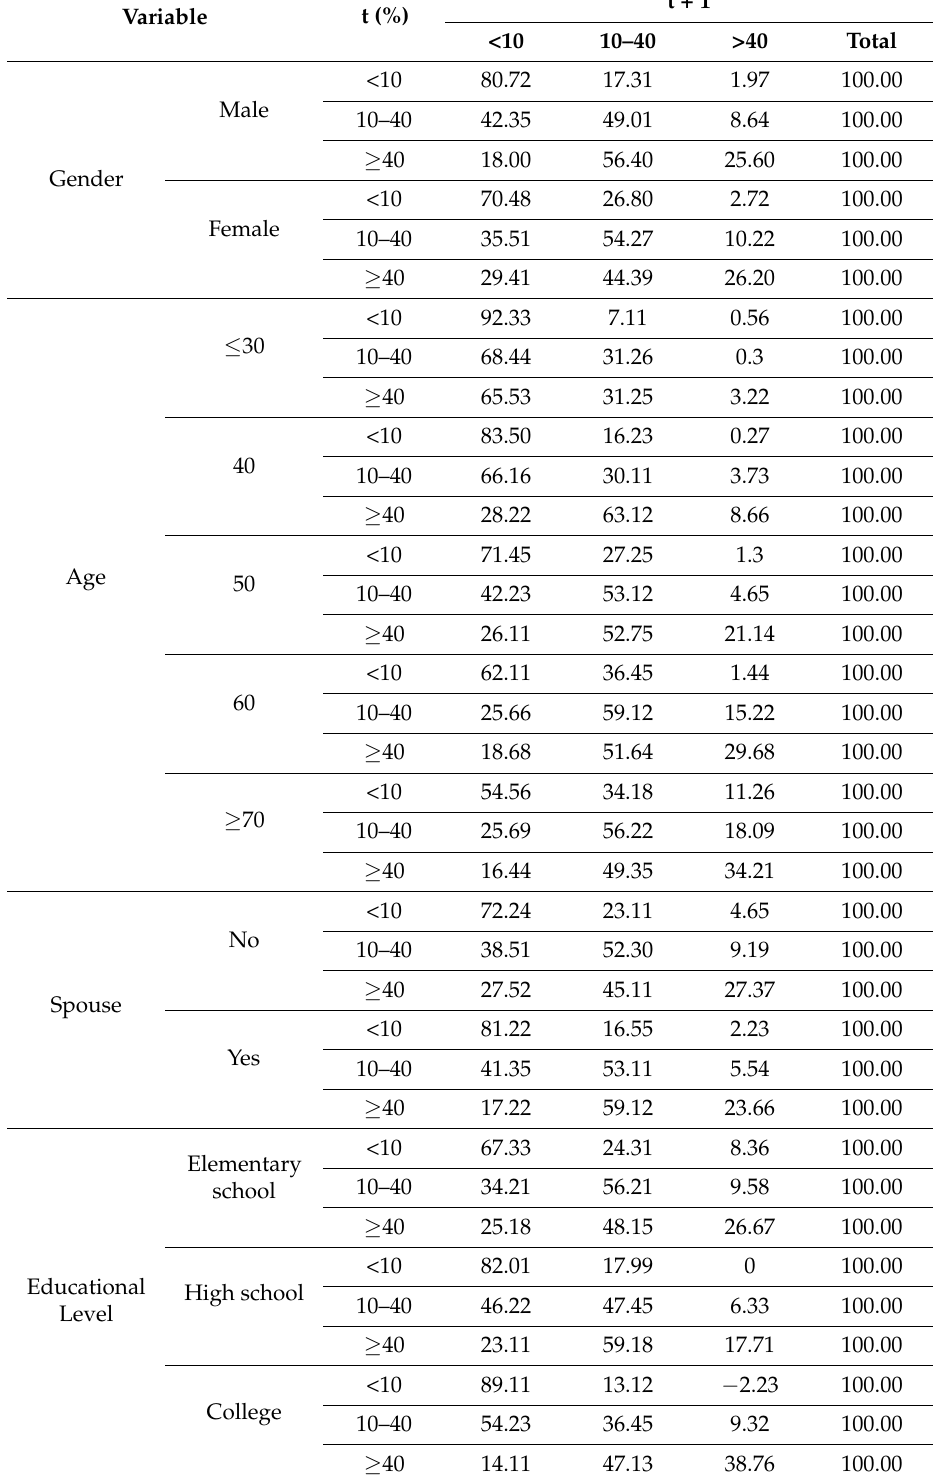
Table 5. Transition probability analysis of catastrophic health expenditure of households with cancer